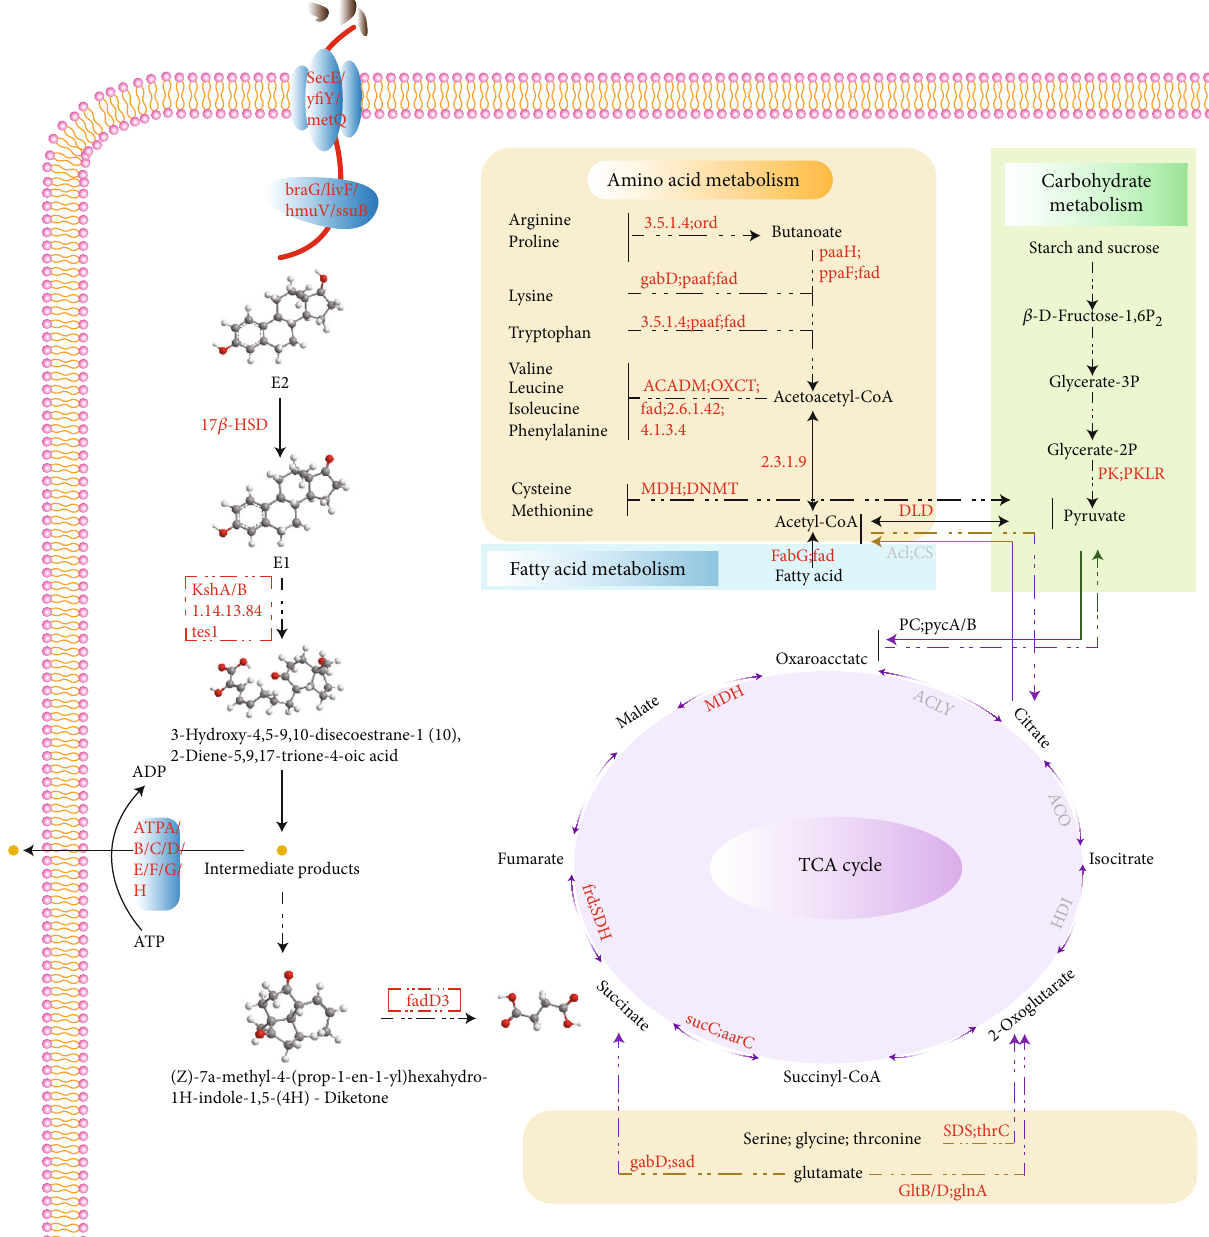
Figure 5: A diagram of the metabolic mechanisms of DEGs that were signi fi cantly upregulated in Strain R-001 under di ff erent estrogen treatments. Upregulated genes are shown in red font, and genes whose expression did not change are shown in gray. Refer to the text for additional details. The gene in the red-dashed line indicates that we believe that it plays a role in the corresponding degradation process, but the speci fi c reaction process involved in it has not been identi fi